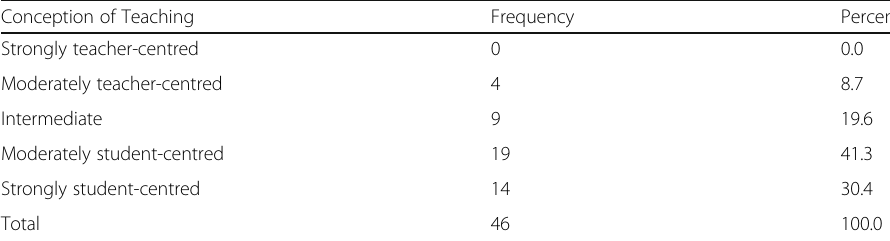
Table 5 Conceptions of teaching